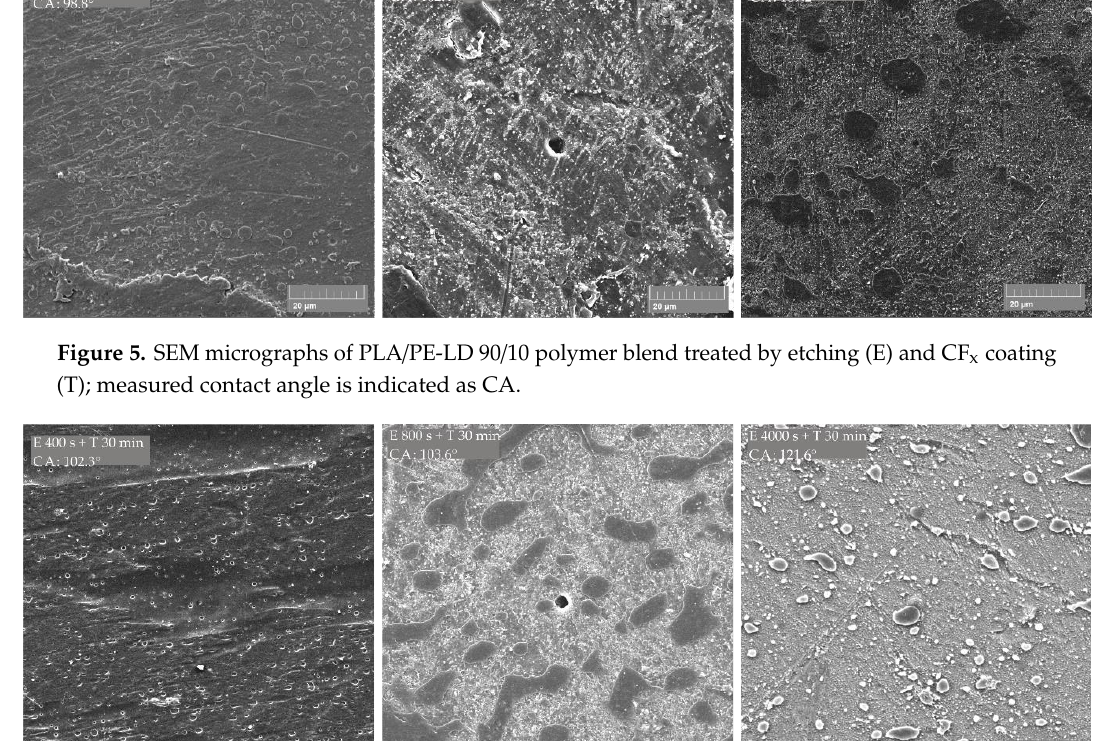
Figure 5. SEM micrographs of PLA/PE-LD 90/10 polymer blend treated by etching (E) and CF x coating (T); measured contact angle is indicated as CA.